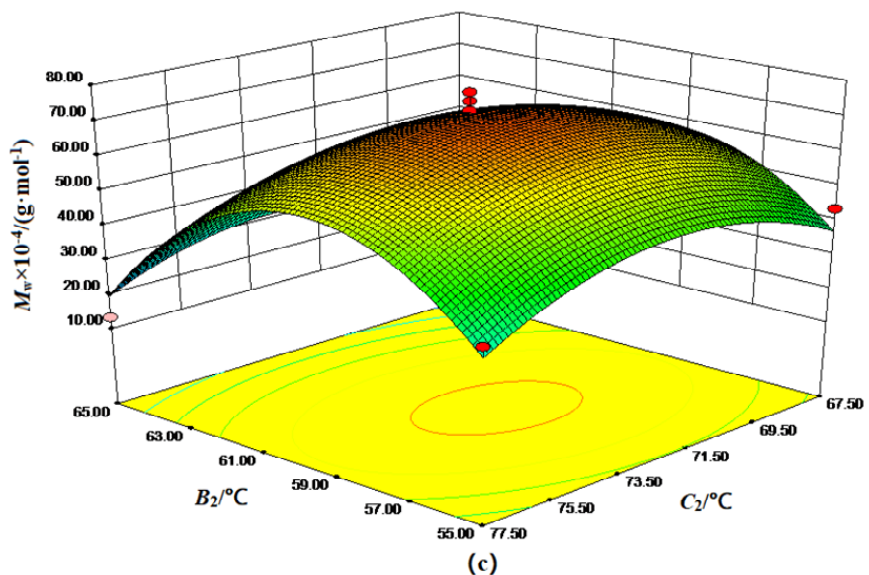
Figure 4. Response surface diagram of M w affected by various factors of polymerization process temperature. ( a ) Response surface diagram of the interaction between A 2 and B 2 of the polymerization process on M w ; ( b ) Response surface diagram of the interaction between A 2 and C 2 of the polymerization process on M w ; ( c ) Response surface diagram of the interaction between B 2 and C 2 of the polymerization process on M w .